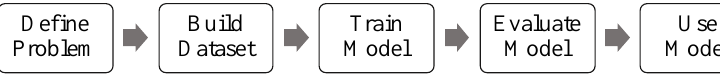
Figure 4. Five steps of machine learning.